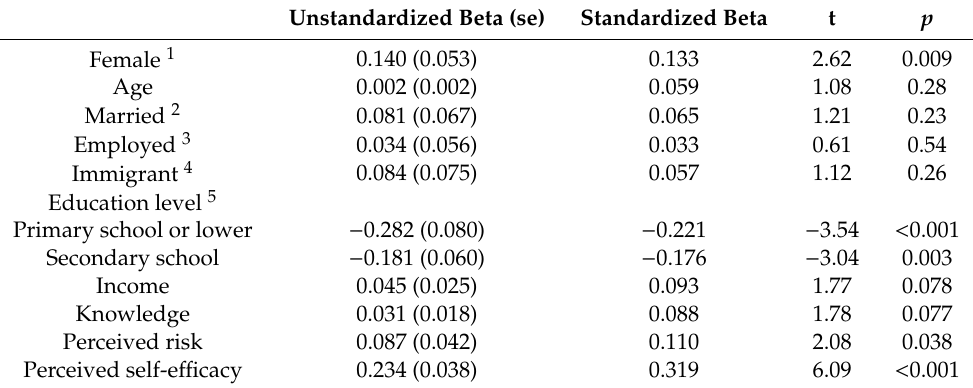
Table 7. Multiple regression analysis on factors associated with preventive